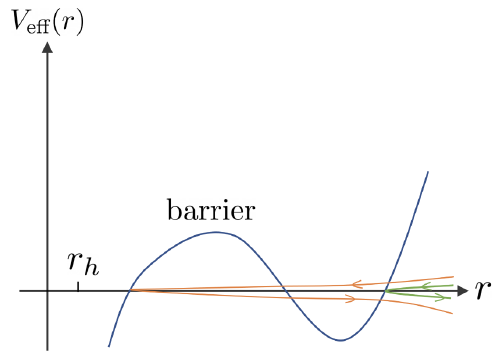
Figure 10 . We can consider a case where there is a potential barrier for the shell separating the near horizon region ( r ∼ r h ) and far away region. In such cases, we expect it to cost more action if the shell is nucleated near the